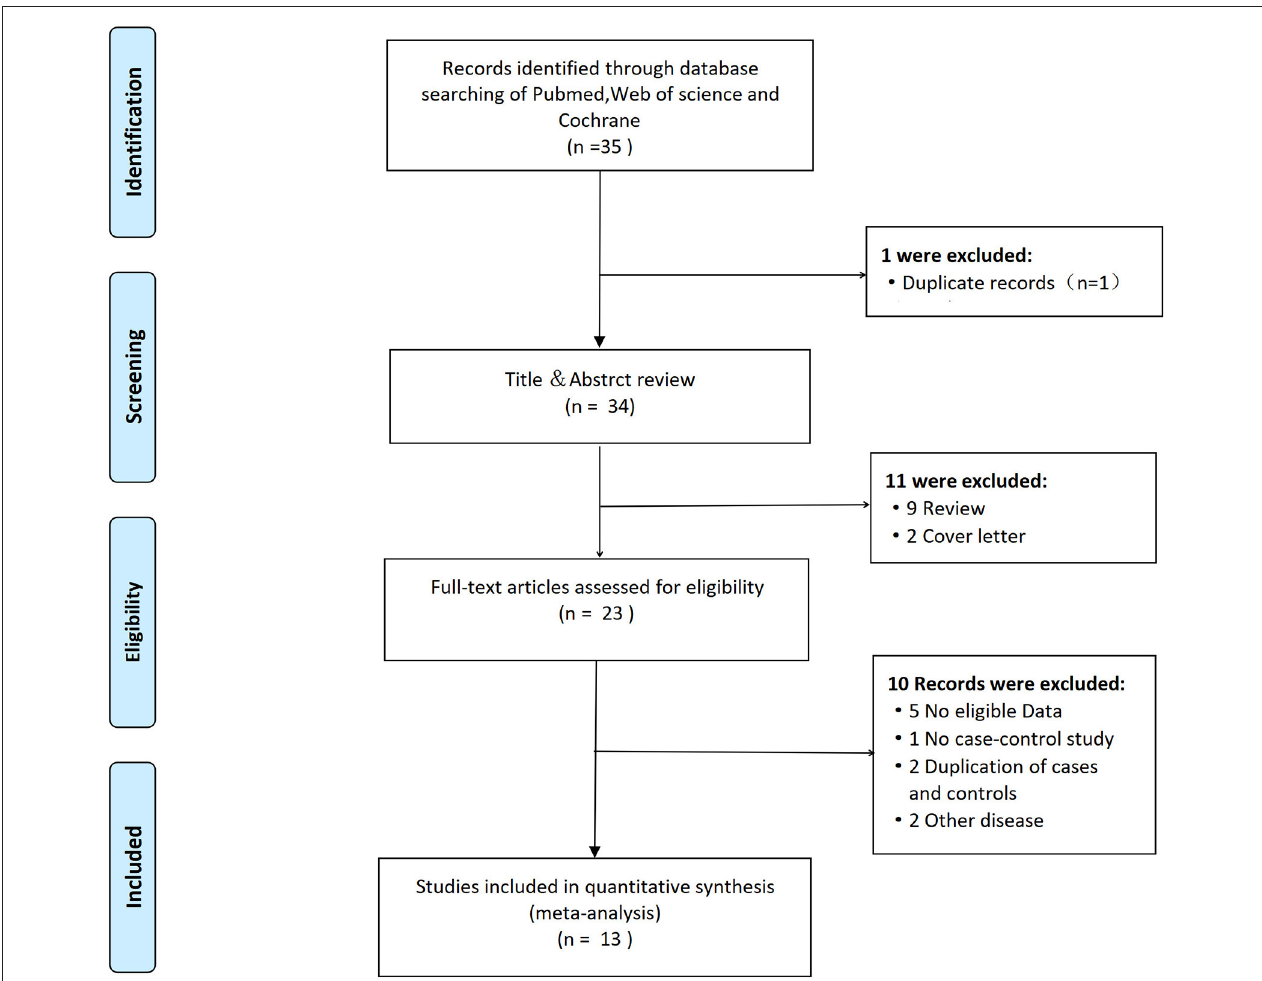
FIGURE 1 | Flow diagram summarizing the search strategy for meta-analysis of 174G/C polymorphism of interleukin-6 (IL-6) and the risk of ischemic stroke.